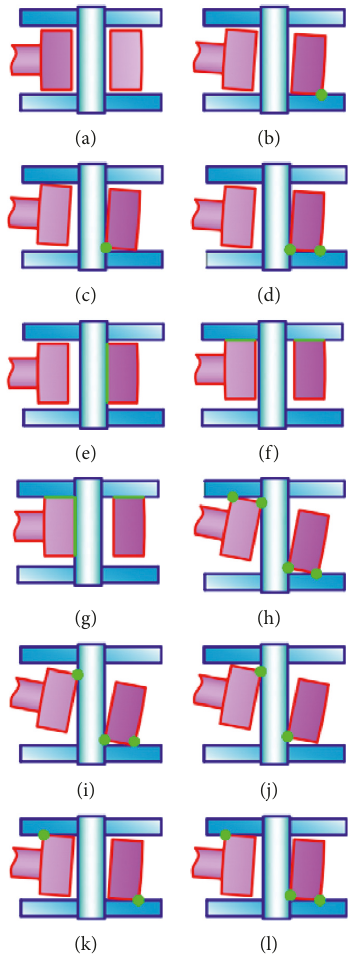
Figure 3: Potential contact scenarios in 3D revolute joint with